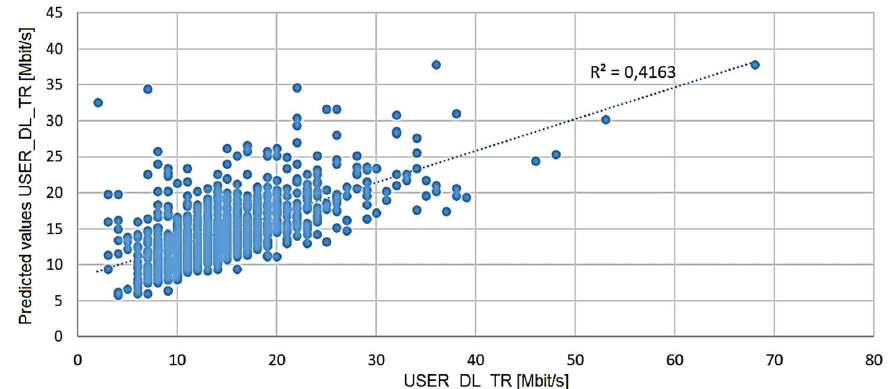
Figure 6. Scatter plot of the prediction results for the M9J P-J section.